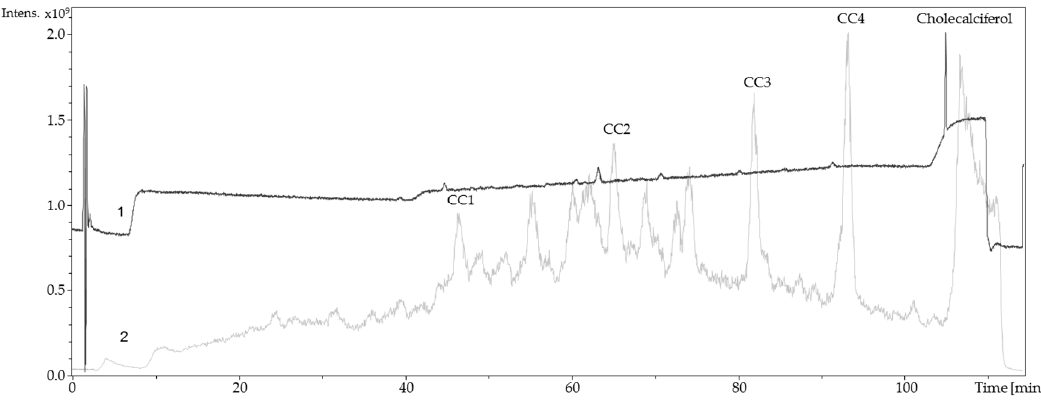
Figure 6. LC-MS / DAD chromatogram of electrochemical oxidized cholecalciferol (2 mM). CCx: Shortcut for cholecalciferol oxidation products; 1: Cholecalciferol, oxidized, UV chromatogram 190–800 nm; 2: Cholecalciferol, oxidized, TIC + All MS.